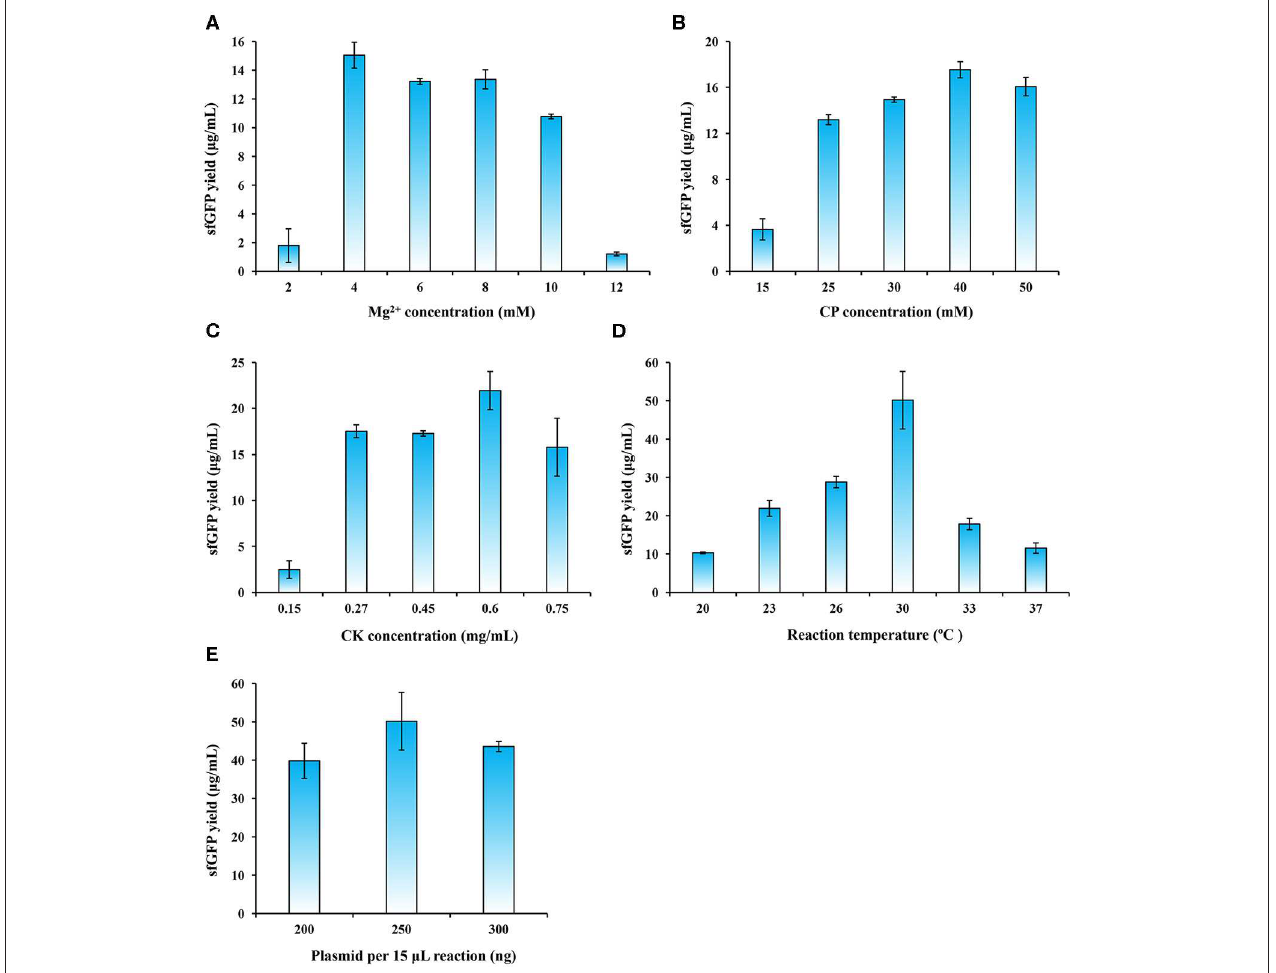
FIGURE 4 | CFPS reaction optimization for enhancing sfGFP expression yields. The CFPS reaction was optimized by altering (A) Mg 2 + concentration, (B) CP (creatine phosphate) concentration, (C) CK (creatine phosphokinase) concentration, (D) reaction temperature, and (E) plasmid concentration for sfGFP synthesis. Values show means with error bars representing standard deviations (s.d.) of at least three independent